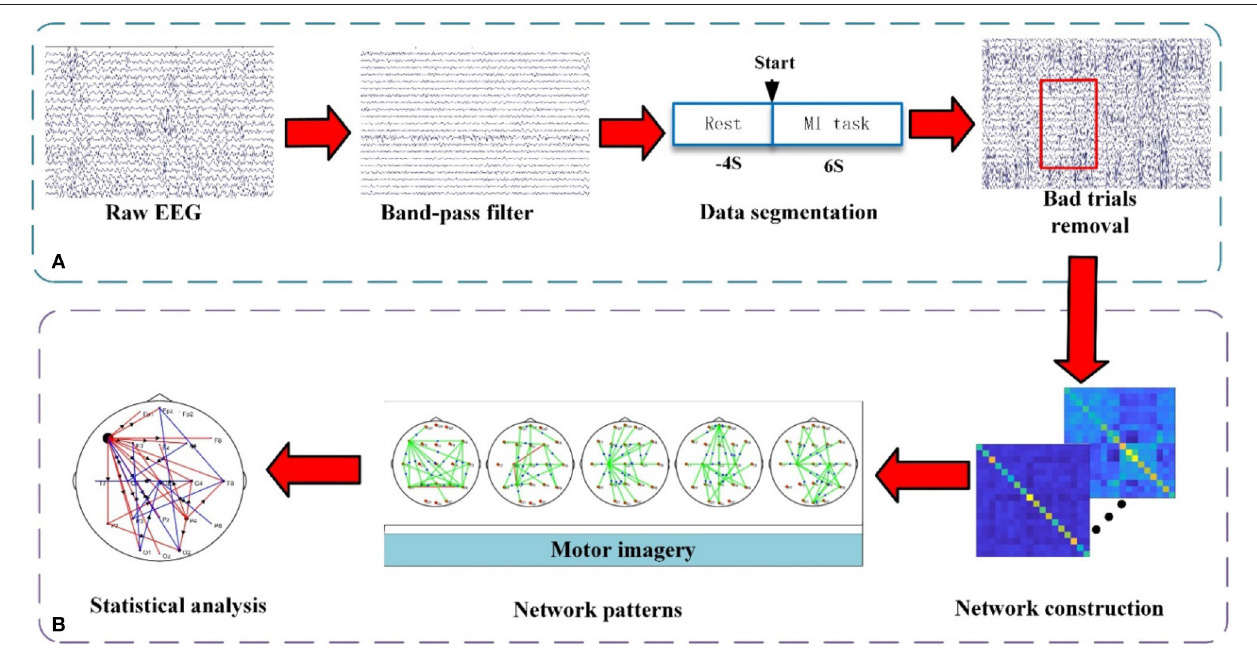
FIGURE 2 | The framework of EEG processing procedure. (A) Preprocessing. (B) Time-varying network pattern analysis. Between the two electrodes, the connecting edge represents the coupling relationship and the arrow represents the flow